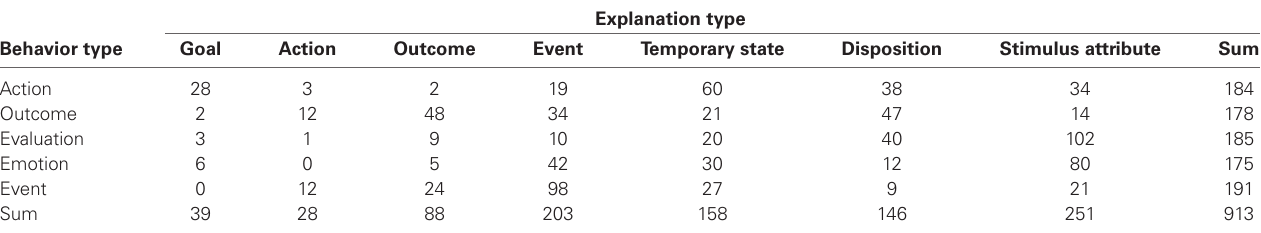
Table 1 | Number of free-response explanations by explanation type and behavior type (Experiment 1).